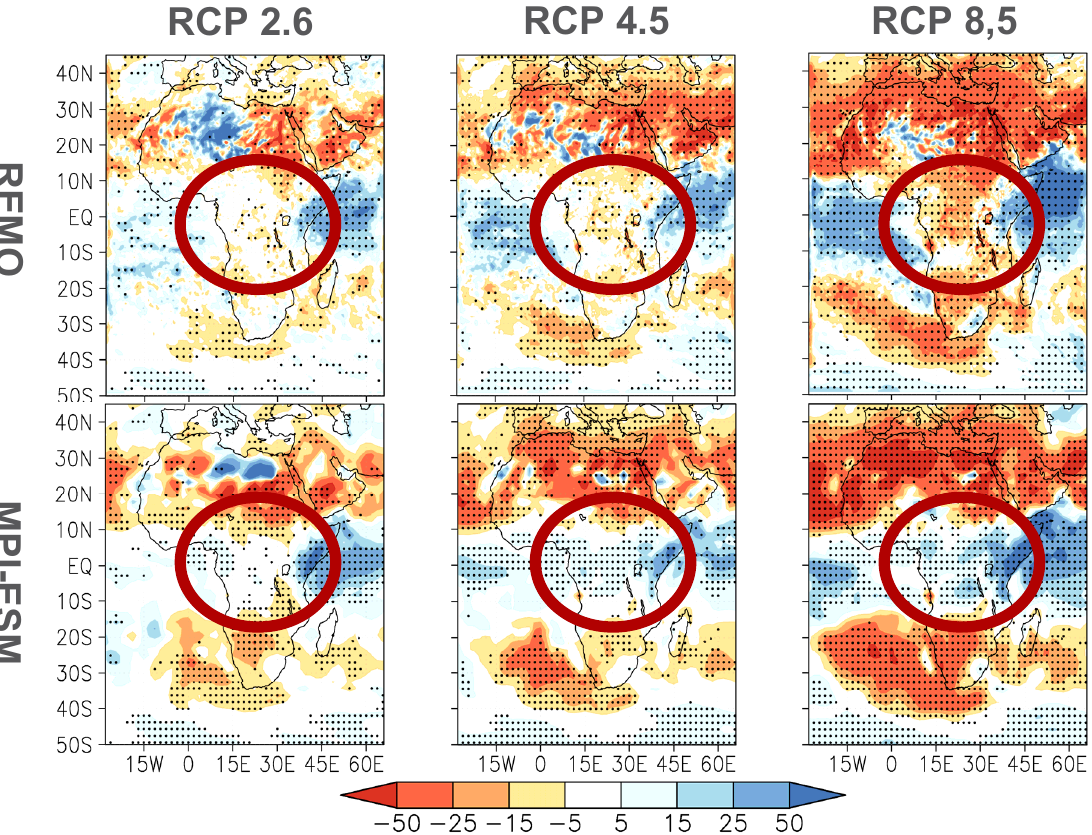
Figure 1. Projected annual mean precipitation change (%) for the 2070–2099 period with respect to the 1970-1999 period. The MPI-ESM data is interpolated on the REMO grid. Dots represent areas with statistically significant changes (95th significance level using Mann-Whitney U-test). The red circles represent the region of contradictory signal between the